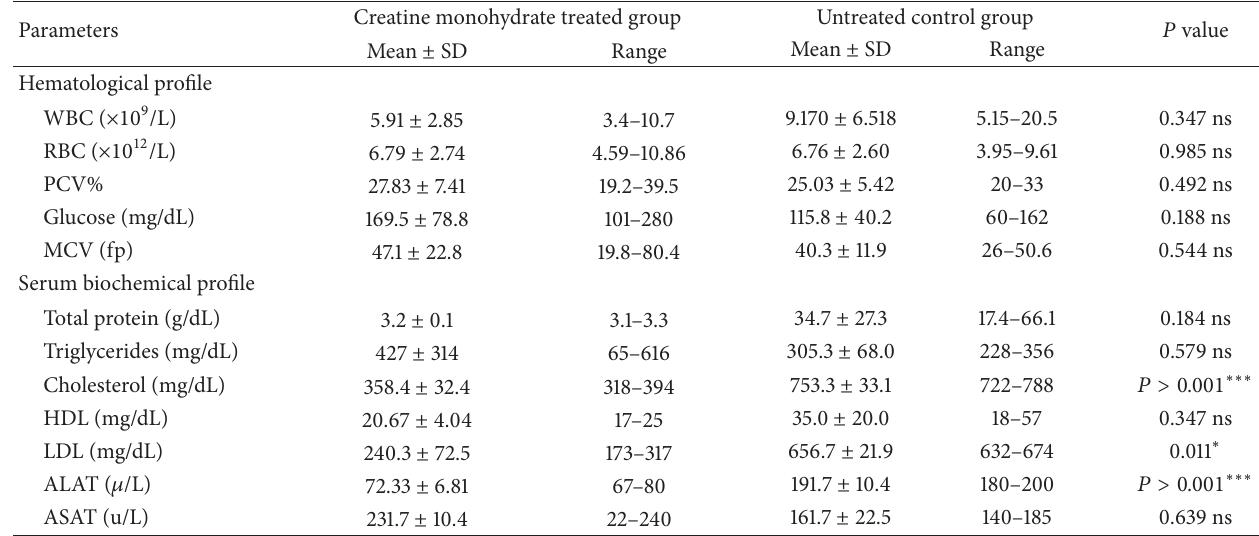
Table 2: Comparison of various hematological and serum biochemical parameters between 2% creatine monohydrate treated and untreated (control) male albino mice for 12 weeks following hypoxia and ischemia: data is expressed as mean ± standard deviation.